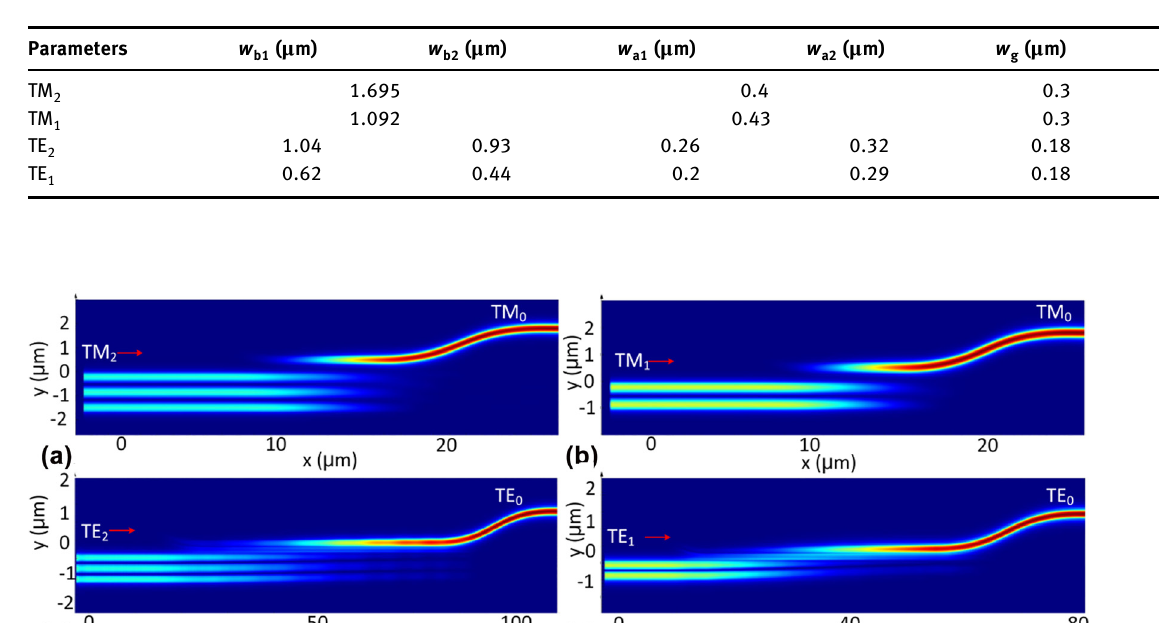
Table 1: Key parameters of couplers for four higher order modes.